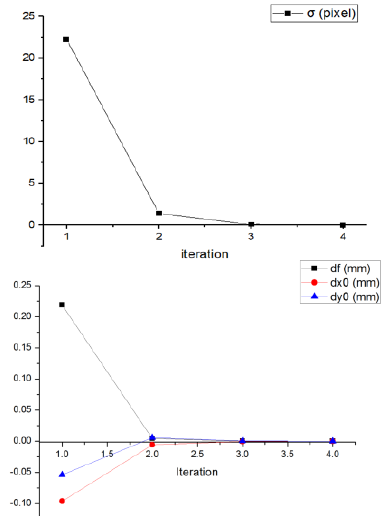
Table 7. The corrections of interior orientation parameters of Trail C